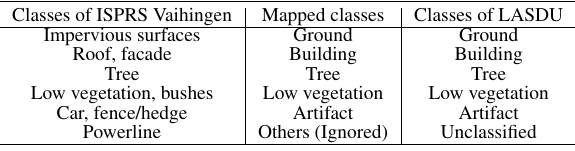
Table 1. Class mapping for ISPRS Vaihingen and LASDU point cloud datasets.